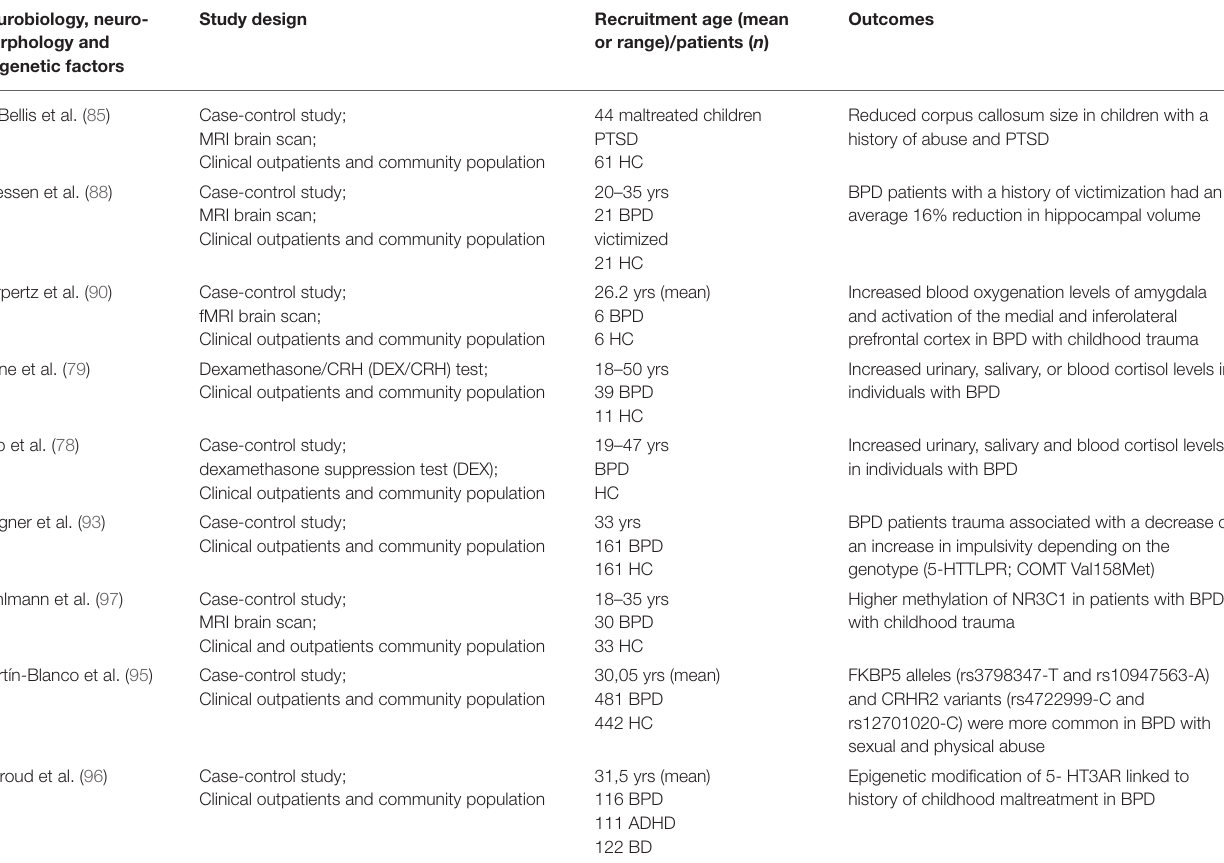
TABLE 3 | Studies on neurobiological, neuro-morphological, and epigenetic factors in early onset BPD. Neurobiology, neuro- morphology and